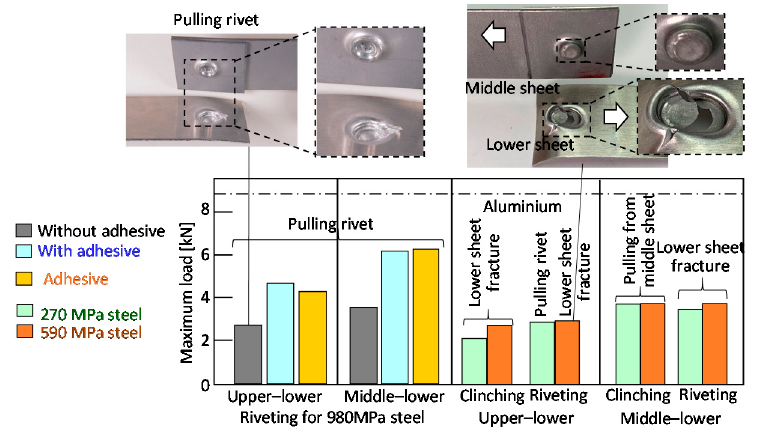
Figure 31. Tension-shearing loads of riveted and clinched joints for the lower aluminium alloy sheet.